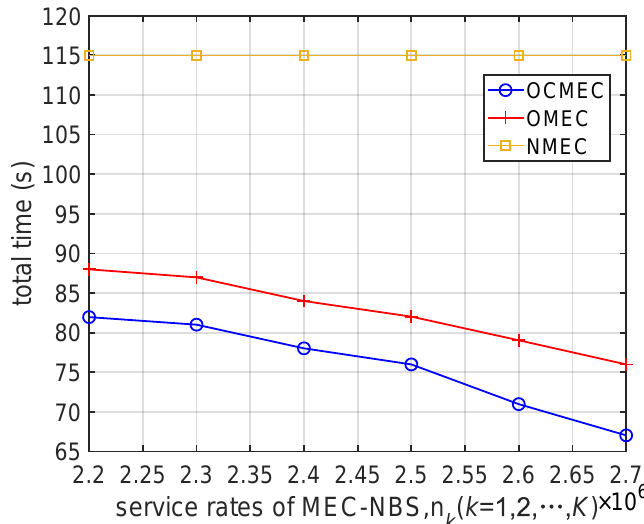
Figure 7. f gained by the 3 schemes with the increase of φ k , the service rate of n k , k = 1,2, . . . , K